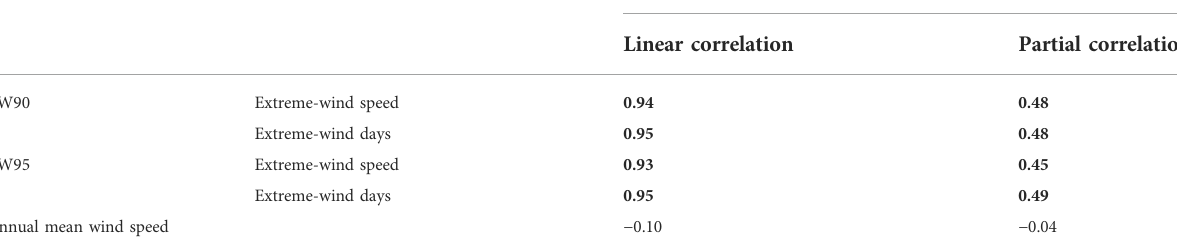
Bold values are the coef fi cients passing the 0.05 signi fi cance level.